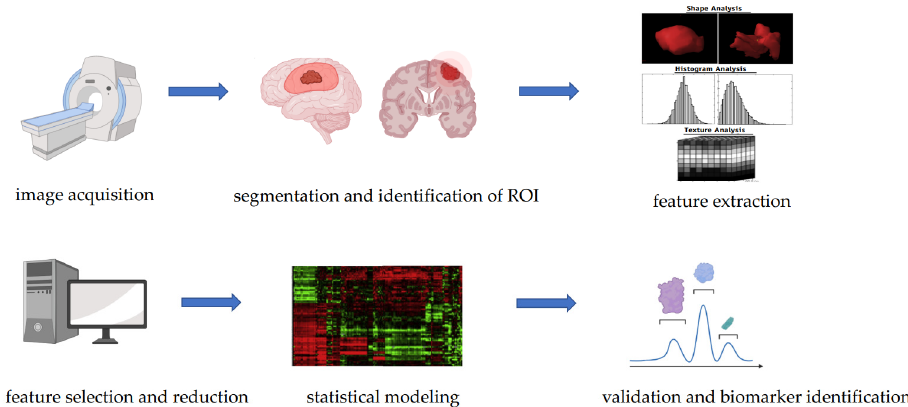
Figure 1. Steps of a radiogenomic study.